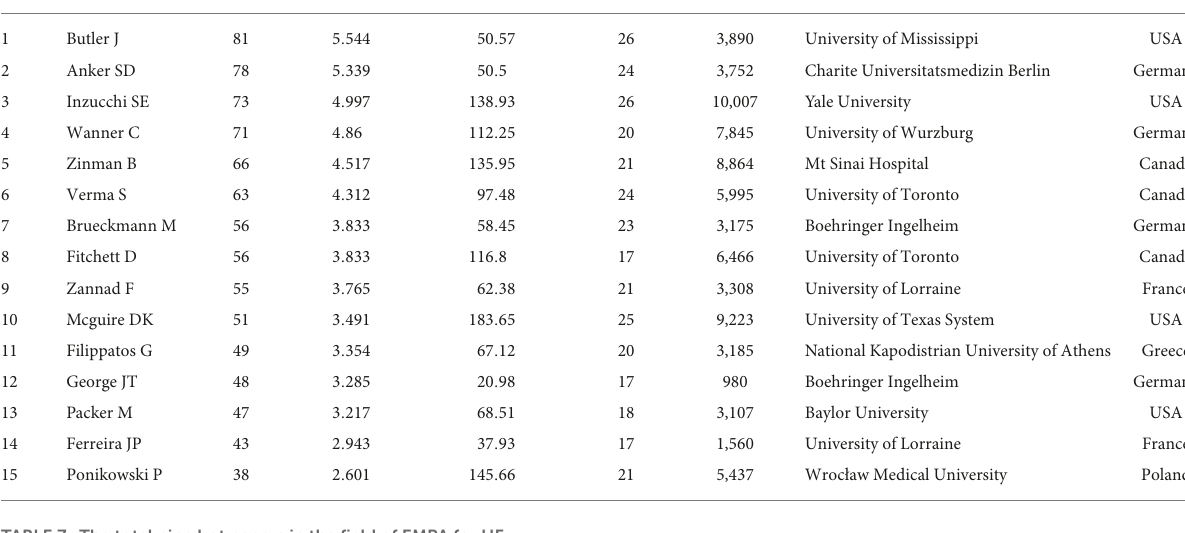
TABLE 6 Top 15 contributing authors in the field of EMPA for HF.